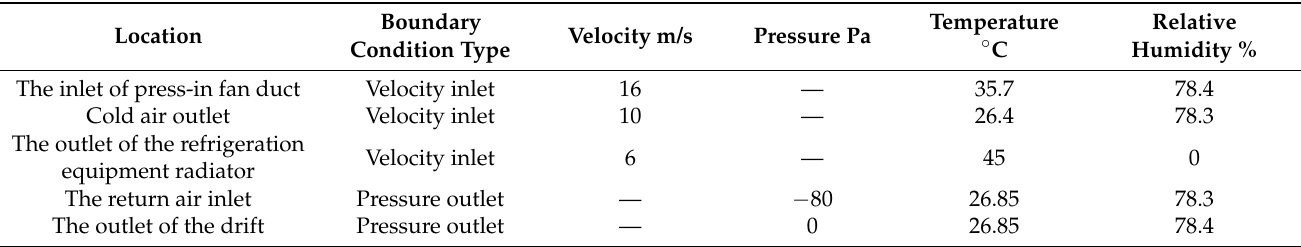
Table 2. Setting of Boundary Conditions for Each Inlet and